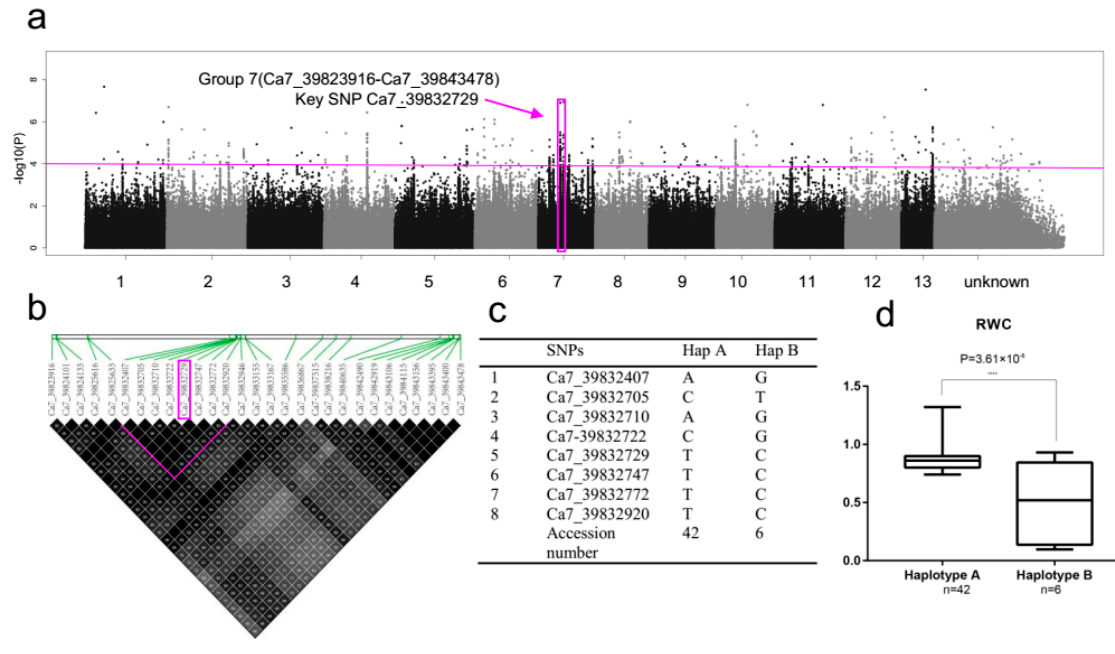
Figure 5. GWAS results for RWC and analysis of the peak on chromosome 7. ( a ) Manhattan plot for RWC. The horizontal line represents the significant threshold ( − log 10 P = 4). The pink color surround represents SNP rich region (Group 7). ( b ) LD surrounding the peak of Group 7. ( c ) Haplotypes in Group 7. ( d ) Phenotypic differences of RWC between two haplotypes.